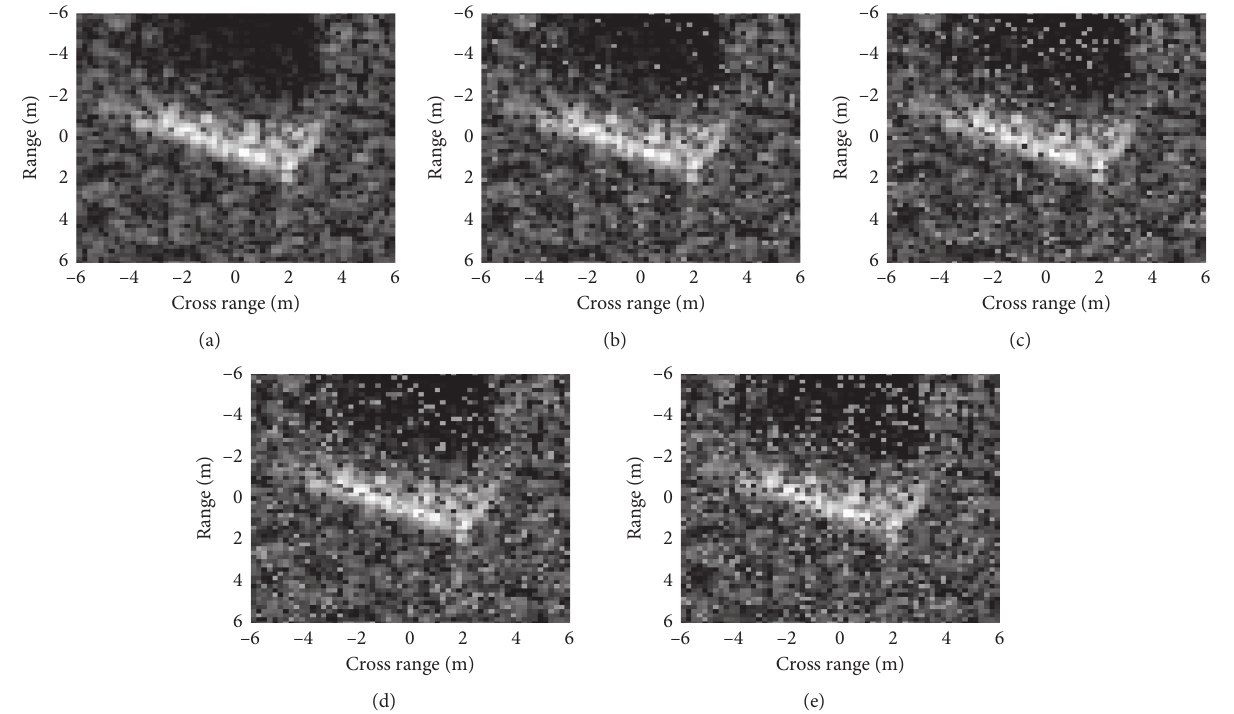
Figure 8: SAR images with random noises: (a) original; (b) 5%; (c) 10%; (d) 15%; (e)